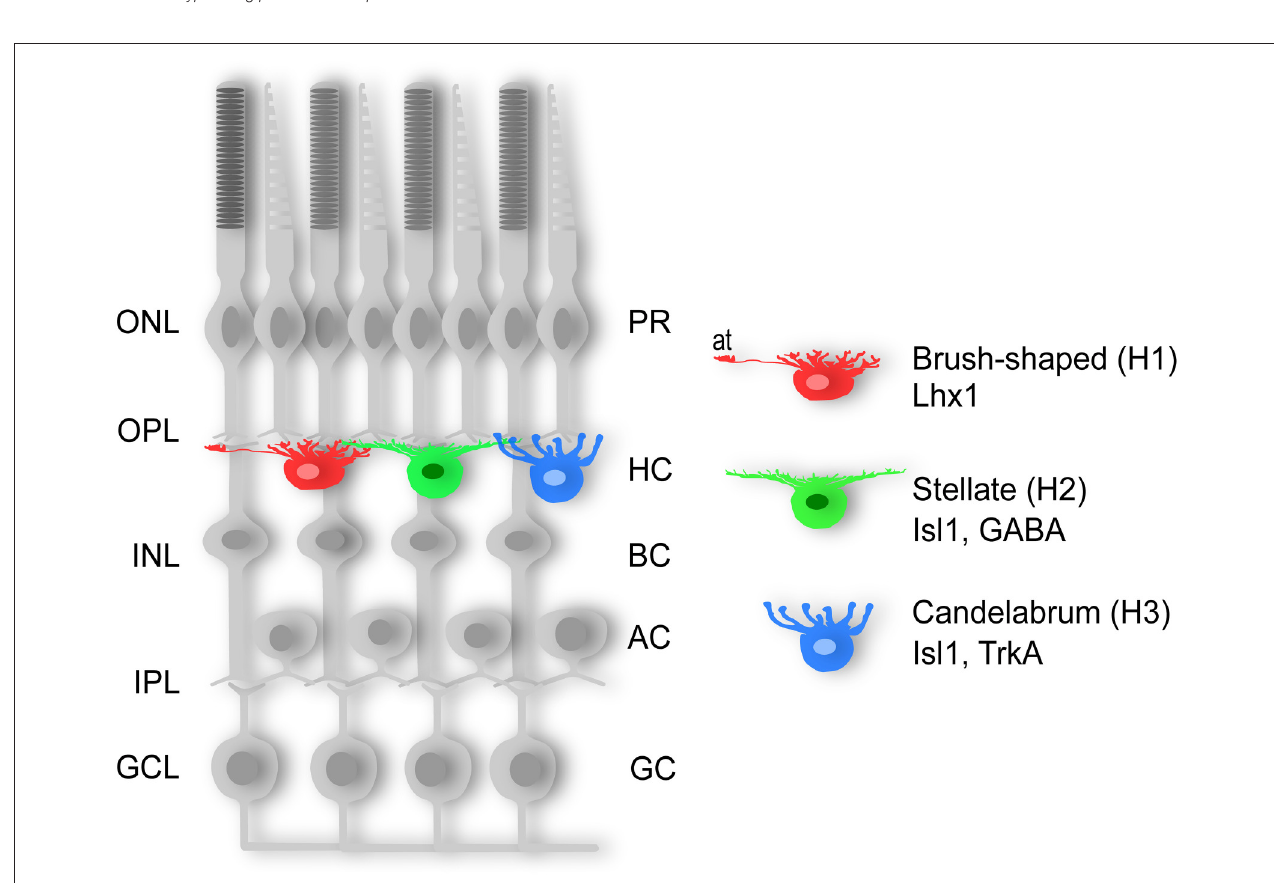
FIGURE 1 | Three horizontal cell types. Schematic diagram of the three subtypes of chicken horizontal cells. The “brush-shaped” (H1) is axon-bearing and expresses Lhx1 (Lim1), whereas the “stellate” (H2) and the “candelabrum-shaped” (H3) are both axon-less and express Isl1. AC; amacrine cell, BC; bipolar cell, GC; ganglion cell, GCL; ganglion cell layer, H1-3; horizontal cell type 1-3, HC; horizontal cell, INL; inner nuclear layer, IPL; inner plexiform layer, ONL; outer nuclear layer, OPL; outer plexiform layer, PR; photoreceptor.